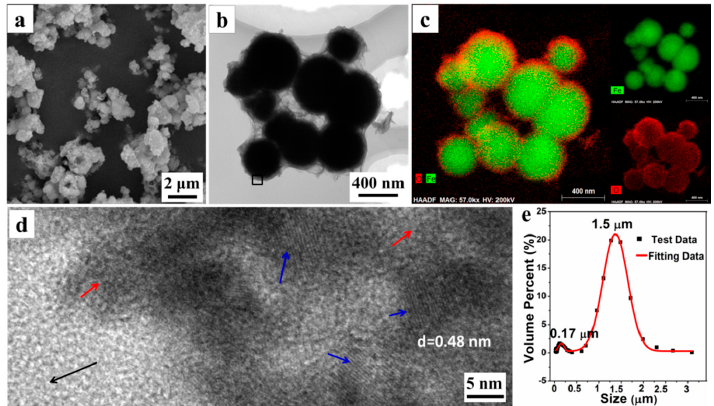
Figure 2. SEM ( a ); TEM ( b ); mapping images ( c ); and HRTEM ( d ) photographs (black arrow: background; red arrow: amorphous; blue arrow: crystal grains); and particle size distribution by LPSA ( e ) of Fe 0 /Fe 3 O 4 microparticles P 0.0525 .